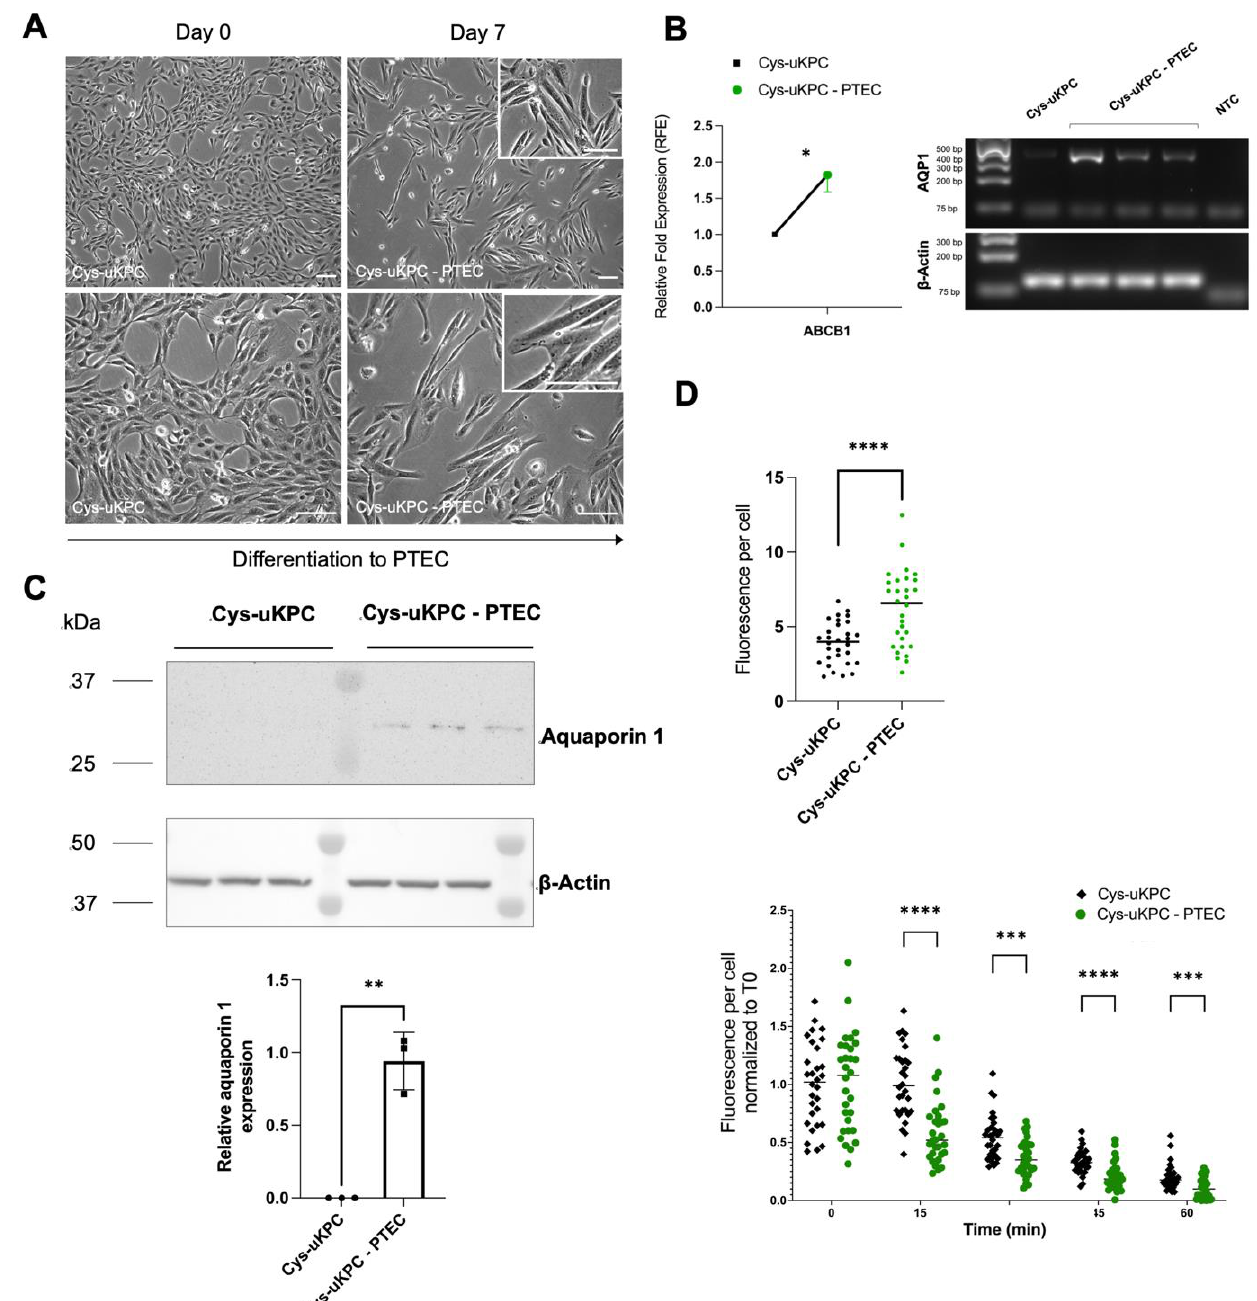
Figure 4. Cys-uKPCs can differentiate in vitro into functional proximal tubular epithelial cells. ( A ) Phase contrast microscopy of a Cys-uKPC clone with a PTEC fate, demonstrating the cellular morphological changes during differentiation (day 0, left column) towards a PTEC (day 7, right column), which is depicted more in specific in the zoomed subpanels in the right upper corner of the microscopy pictures in the right column. Scale bar: 100 μ m. Results depicted originate from Cys-uKPC clone #7; ( B ) ( left ) qPCR analysis of PTEC-specific gene expression in Cys-uKPC-PTEC relative to β -actin and normalized to Cys-uKPCs of a Cys-uKPC clone (Cys-uKPC #7) with a PTEC fate. Cys-uKPC-PTEC data is indicated with a green dot, which represents the mean with bars representing